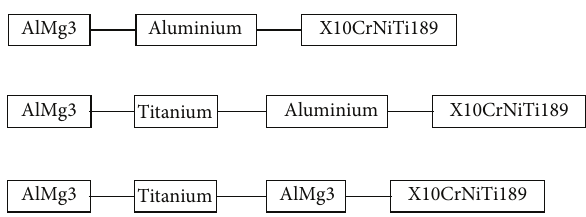
Figure 18: The scheme of forming the AlMg3 aluminium alloy- X10CrNiTi189 austenitic steel joint, with